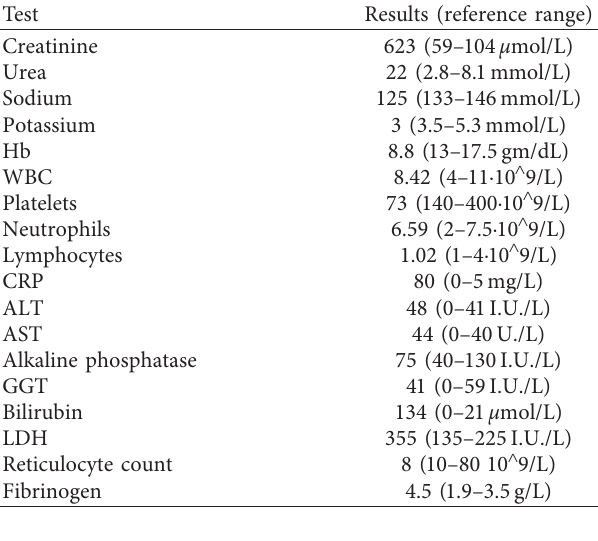
Table 1: Investigation results.